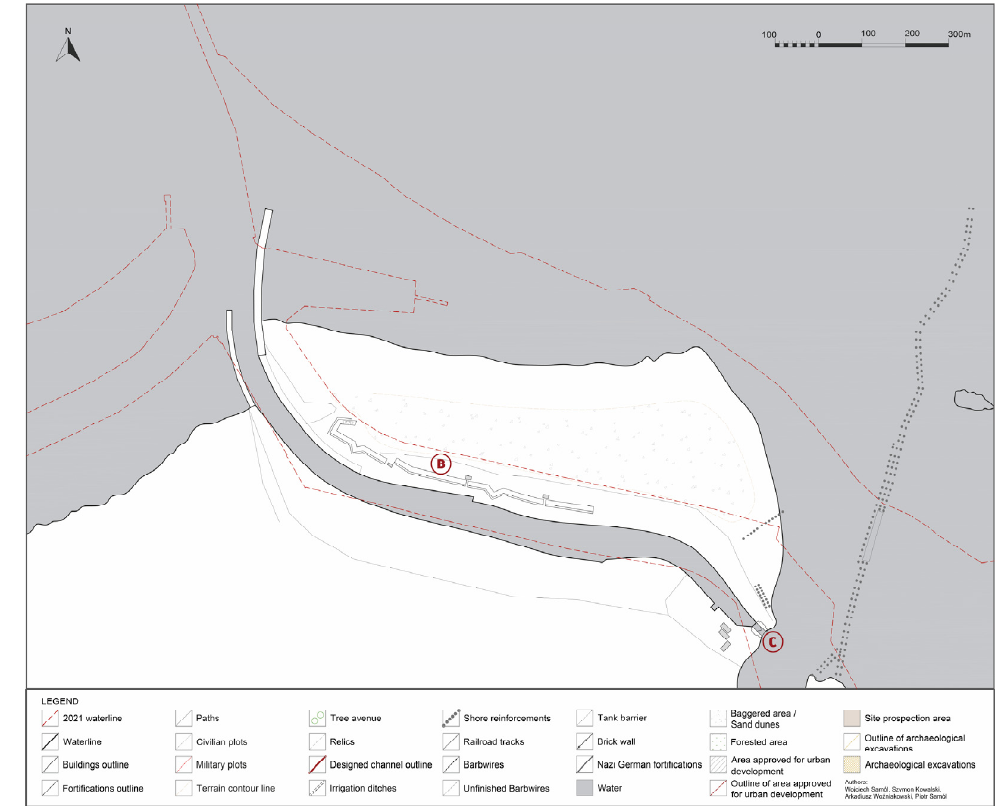
Figure 5. Westerplatte with French fortifications (after